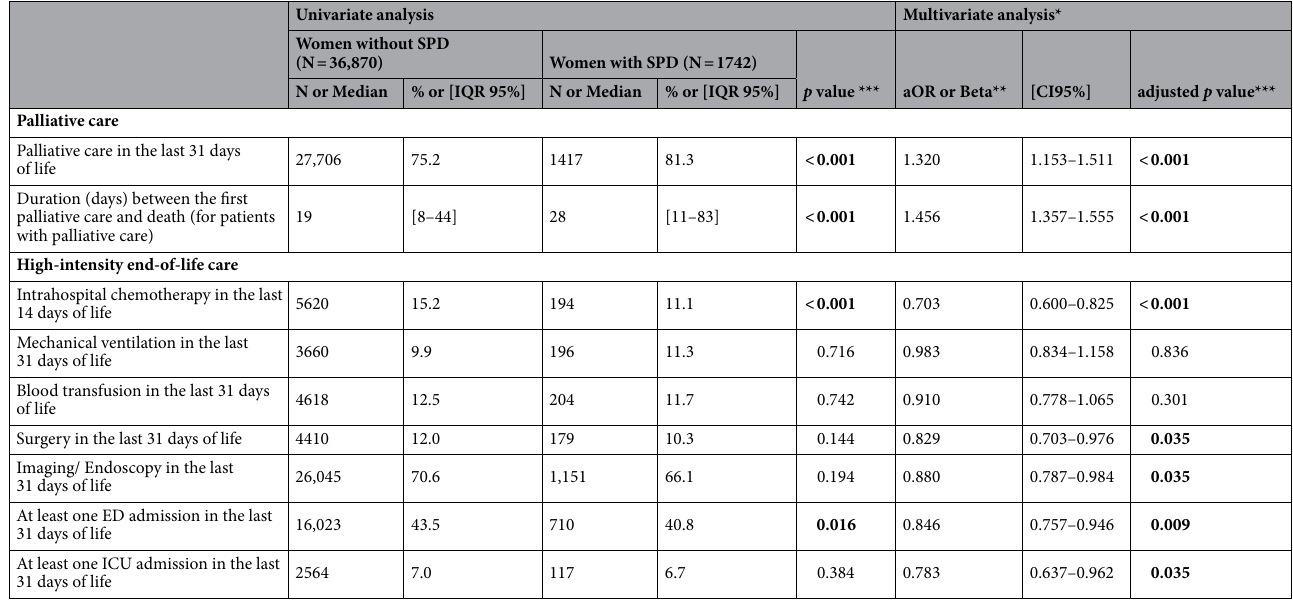
Table 2. Comparison of end of life palliative and high-intensity care of terminal breast cancer between women with and without SPD. N number of patients, % percentage, aOR adjusted odds ratio, CI95% 95%